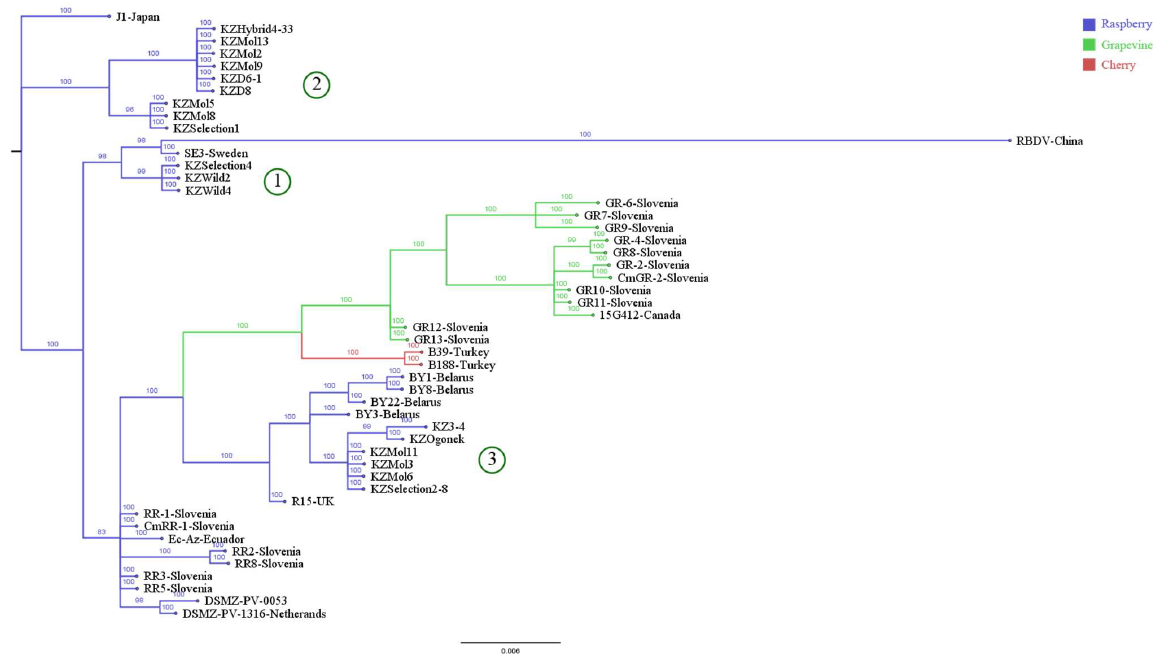
Figure 4. Phylogenetic analysis constructed from all publicly available MP sequences using Bayesian algorithm. Branches are coloured according to the plant host. Kazakhstani cluster (1), (2) and (3) are congruent with the Figure 3.